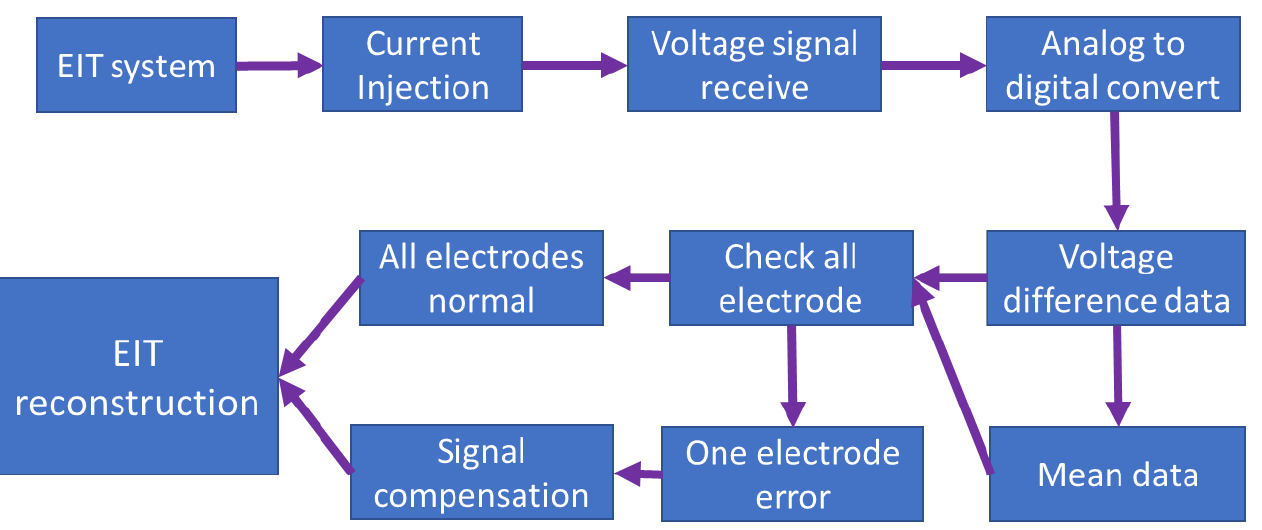
Figure 9. A block diagram of the 16 electrodes EIT system with compensation for invalid data.